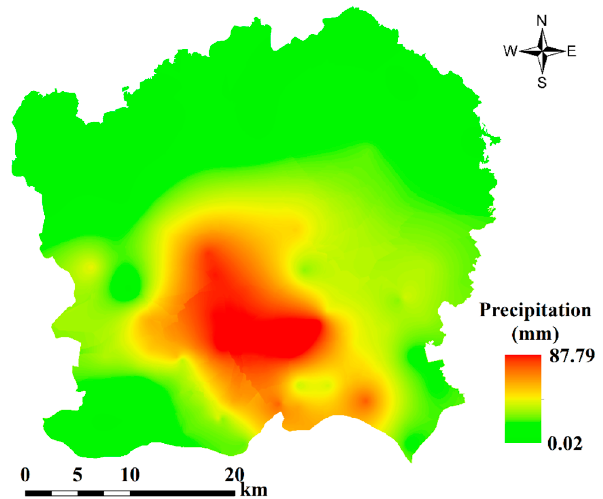
Figure 15. Precipitation map generated by the Kriging method at 1 p.m., 4 May 2015.